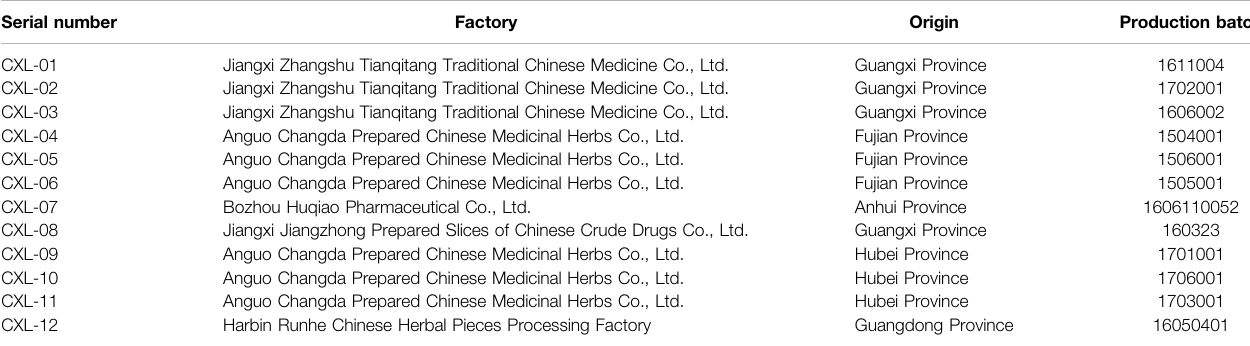
TABLE 2 | Information of A. paniculata sample.